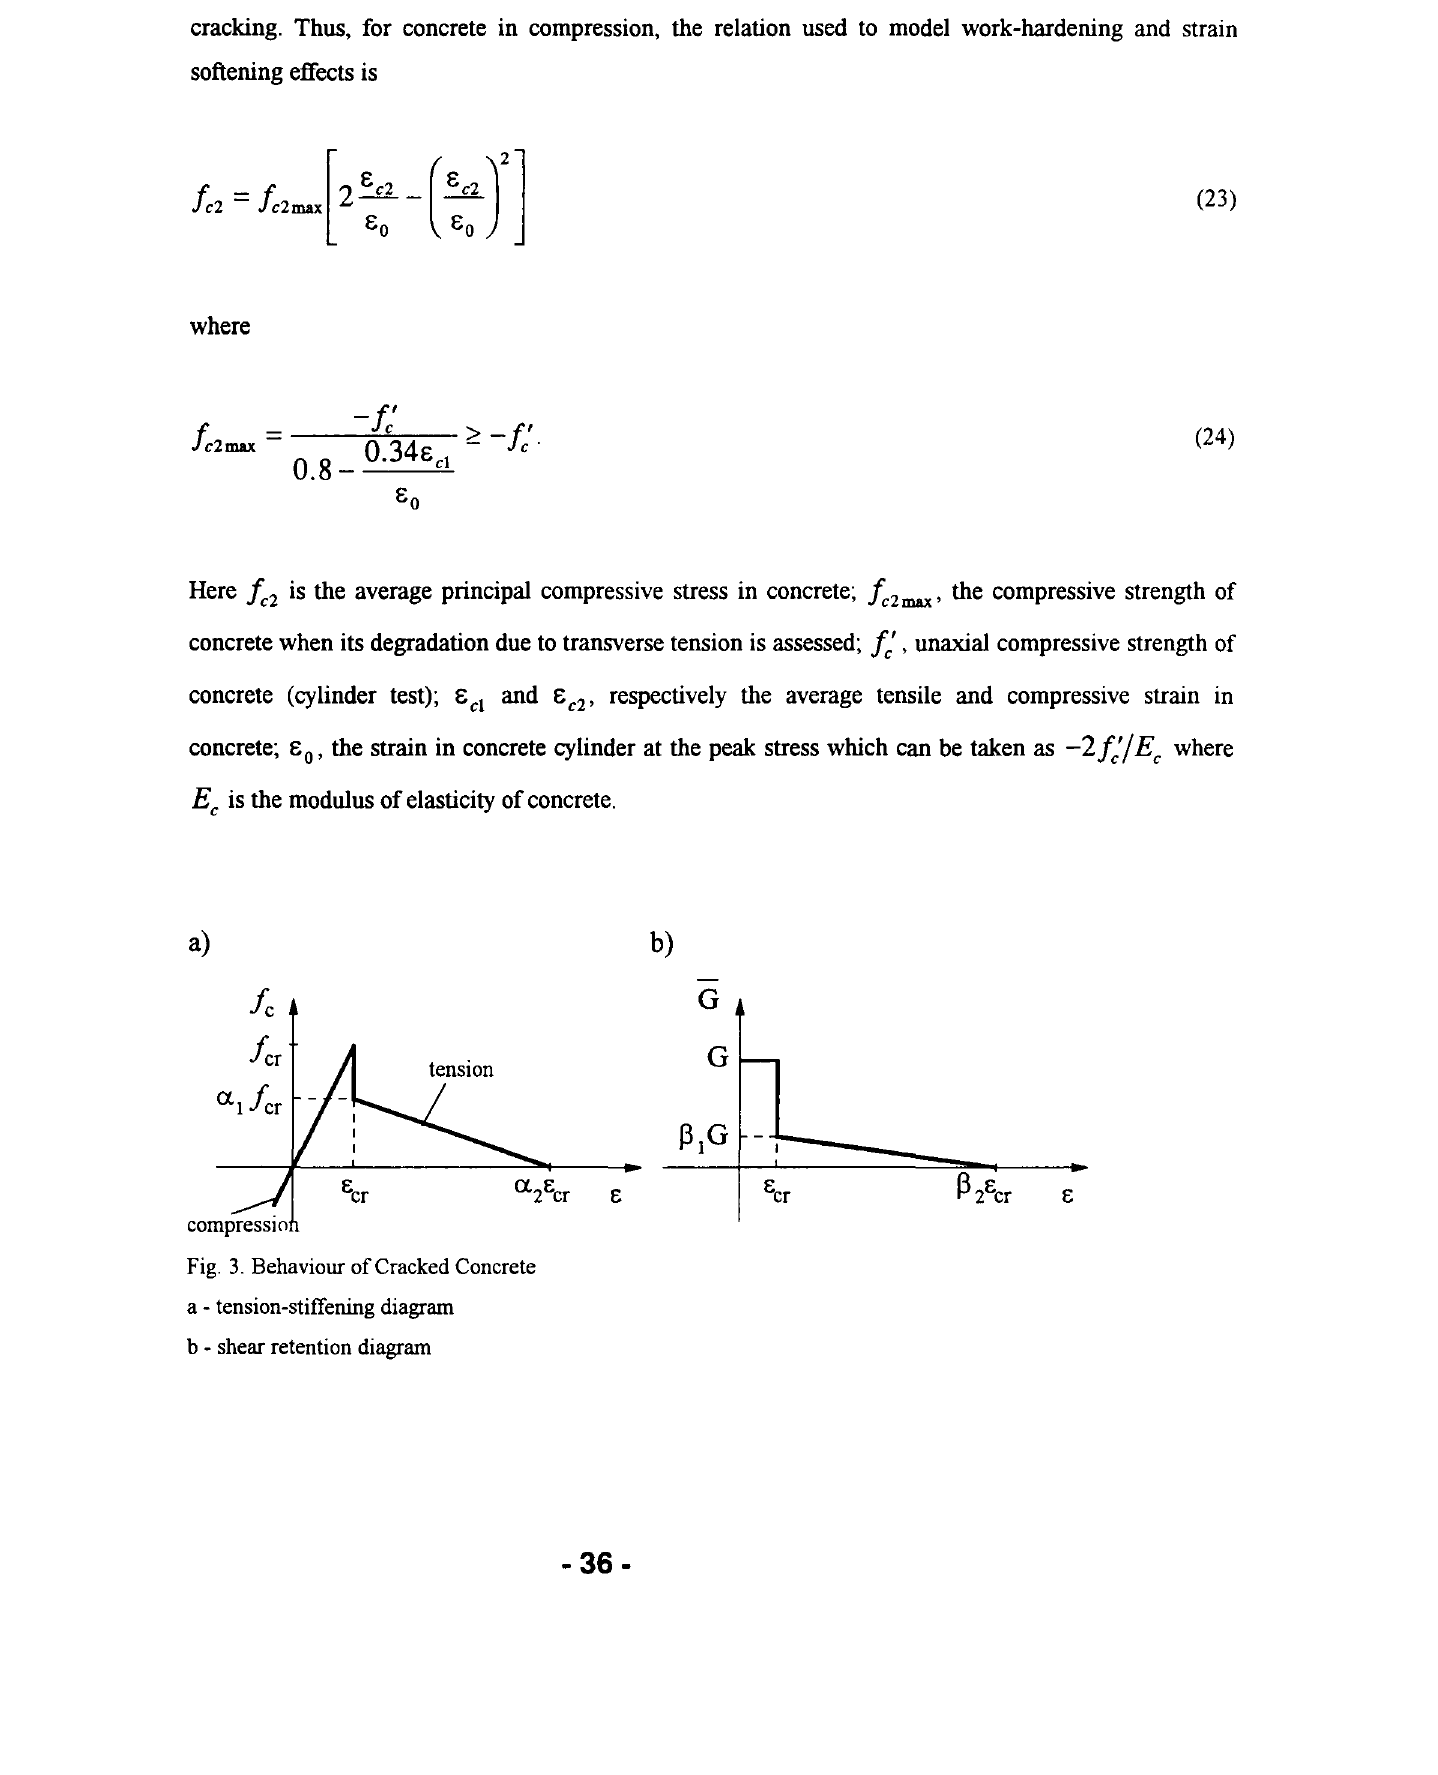
Fig. 3. Behaviour of Cracked Concrete a - tension-stiffening diagram b - shear retention